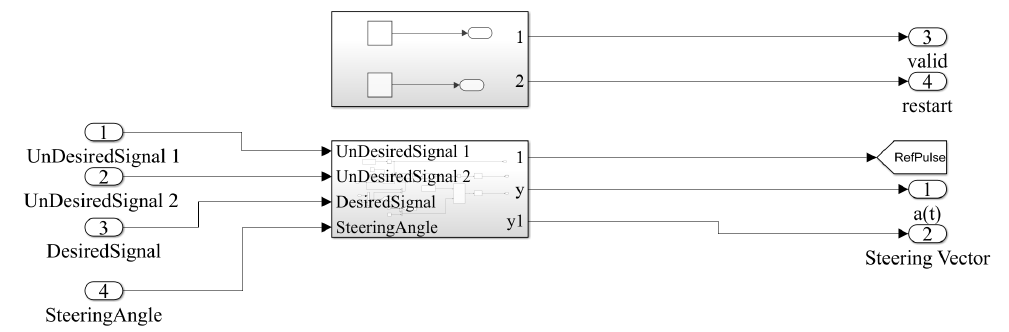
Figure 4. A demonstration of the spatial LCMV beamforming technique in the real environment integrated with the FPGA blocks. The direction of the desired source is 45 ◦ . However, two other directions of 50 ◦ and 30 ◦ impinge on the hybrid array antennas as unwanted signals. The LCMV beamforming technique is capable of spatially filtering unwanted signals.